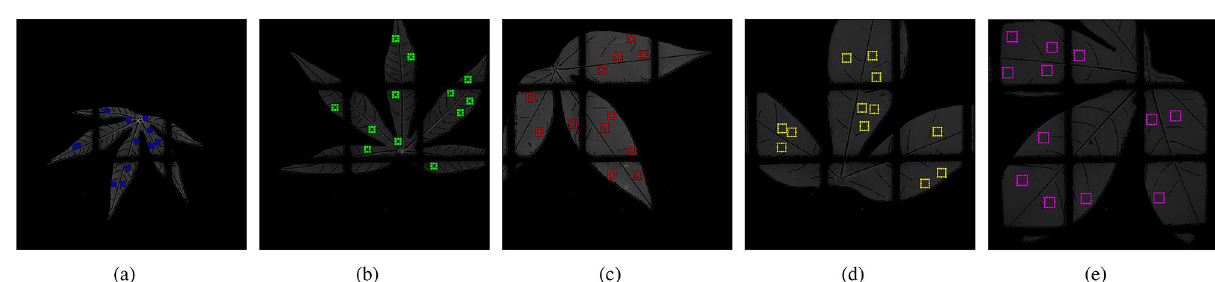
Figure 2. Randomly selected patches of various sizes sampled from leaf areas, avoiding leaf clapping grid and main veins. Patch sizes (pixels): ( a ) 16 × 16 , ( b ) 24 × 24 , ( c ) 32 × 32 , ( d ) 40 × 40 and ( e ) 48 × 48